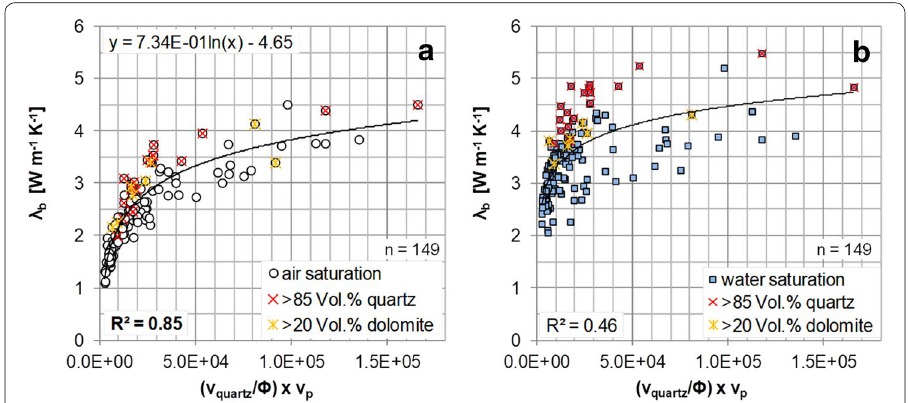
Fig. 12 Cross-plots of bulk thermal conductivity ( λ b ) versus the product of the ratio of quartz volume fraction ( v quartz )/ Φ and v p for a air-saturated sandstone samples, b water-saturated sandstone samples. In case of air-saturated samples, the optimum correlation R 2 0.85 is achieved for plots bulk thermal conductivity ( λ b ) = versus the product of the ratio of quartz volume fraction ( v quartz )/ Φ and v p . λ b and v p are measured parallel